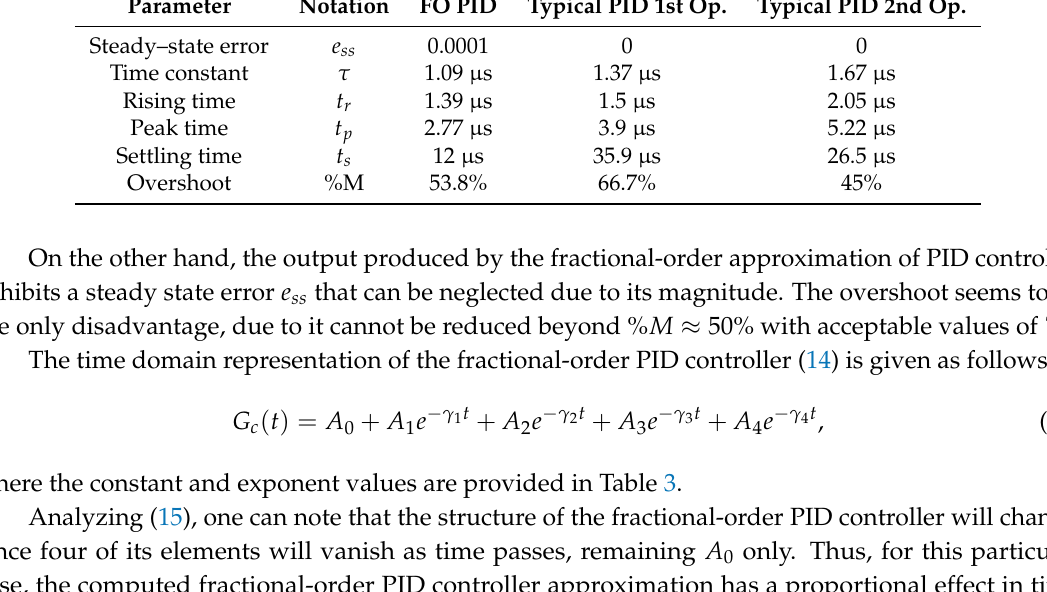
Table 2. Performance parameters for the step response of the Buck converter in Figure 1 described by (4). Parameter Notation FO PID Typical PID 1st Op. Typical PID 2nd